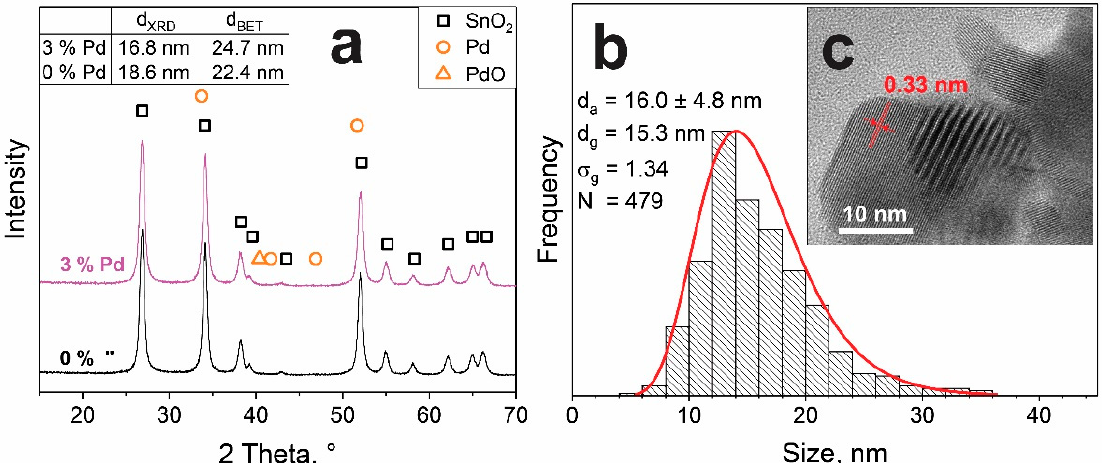
Figure 1. ( a ) XRD patterns of pure (0%) and 3 mol% Pd-loaded SnO 2 . Inset gives the crystal (d XRD ) and primary particle sizes from N 2 -adsorption (d BET ). ( b ) Primary particle size distribution of 3 mol% Pd-loaded SnO 2 determined by electron microscopy and fitted with a log-normal curve (red line) with the arithmetic mean (d a ), geometric mean (d g ), geometric standard deviation ( σ g ), and number of counted particles (N). ( c ) Representative microscopy image of 3 mol% Pd-loaded SnO 2 . The (1 1 0) lattice spacing of SnO 2 is indicated as 0.33 nm.